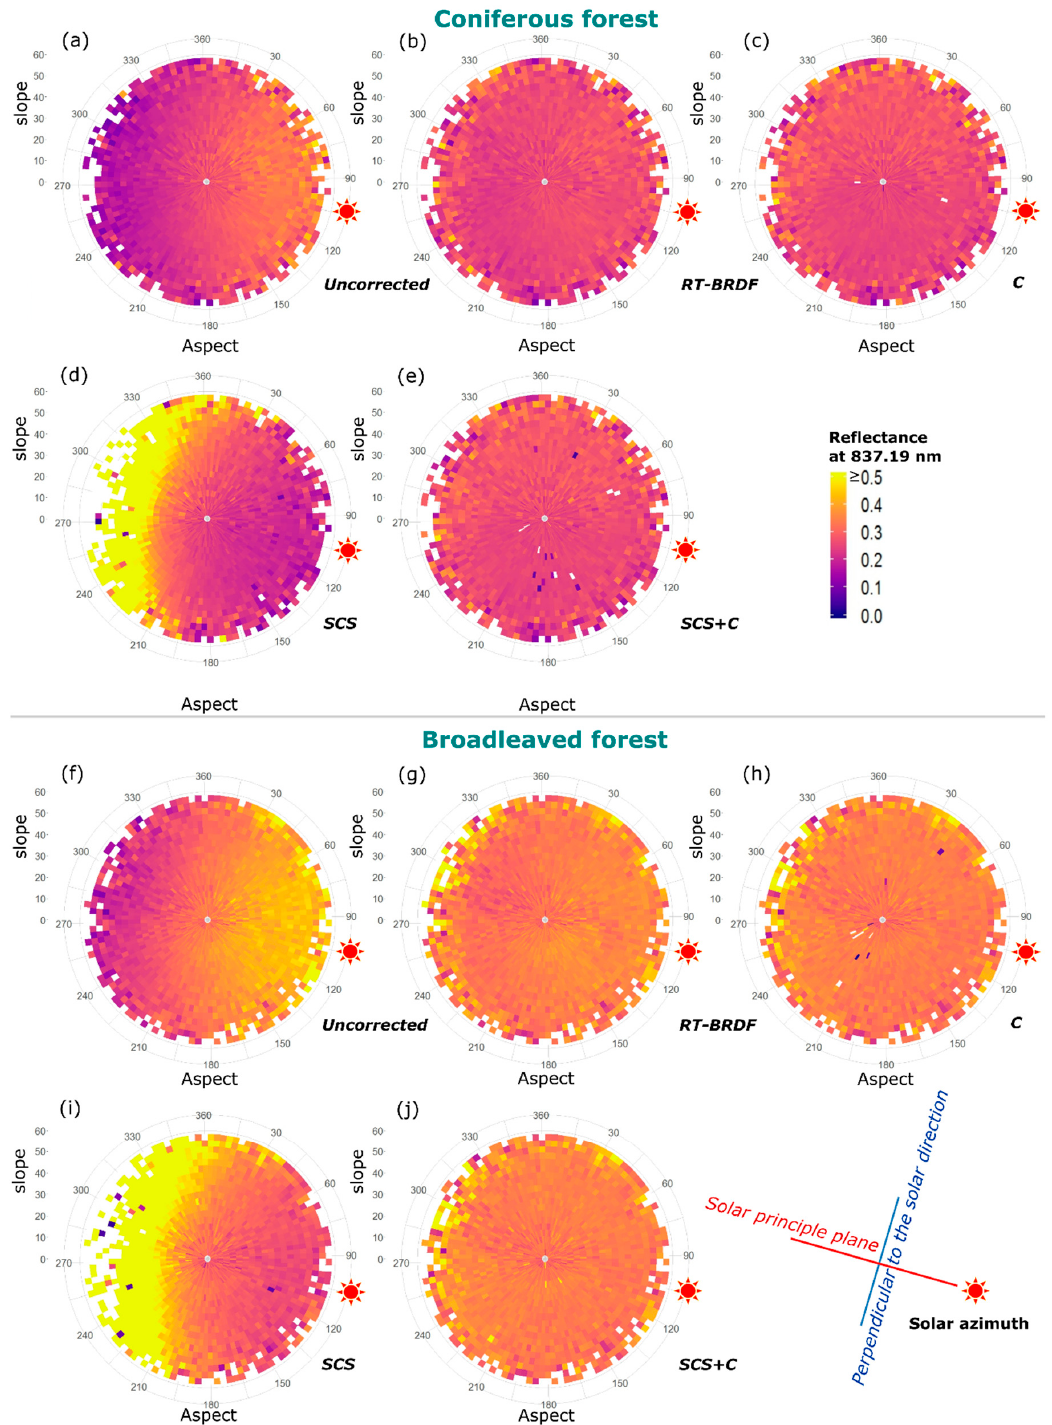
Figure 8. Bottom-Of-Atmosphere (BOA) apparent reflectance of coniferous ( a – e ) and broadleaved ( f – j ) forest pixels at 837.19 nm as function of slope and aspect. Slope and aspect are shown in polar coordinates, with color coded reflectance values at 837.19 nm. The sun pattern denotes the solar azimuth of approximately 100.8°, with the sketch showing solar principle plane and its perpendicular. Blanks in the polar coordinate maps indicate missing reflectance values at the specific slope and aspect or invalid corrected reflectance values.